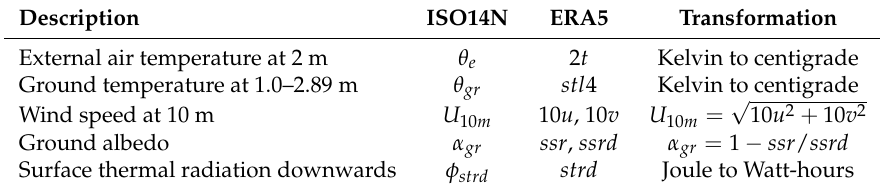
Table 3. Environmental variables derived from ERA5. The ISO14N column shows variable names as they are used in this paper, while the ERA5 column shows the variables sourced from ERA5 according to the notation convention of